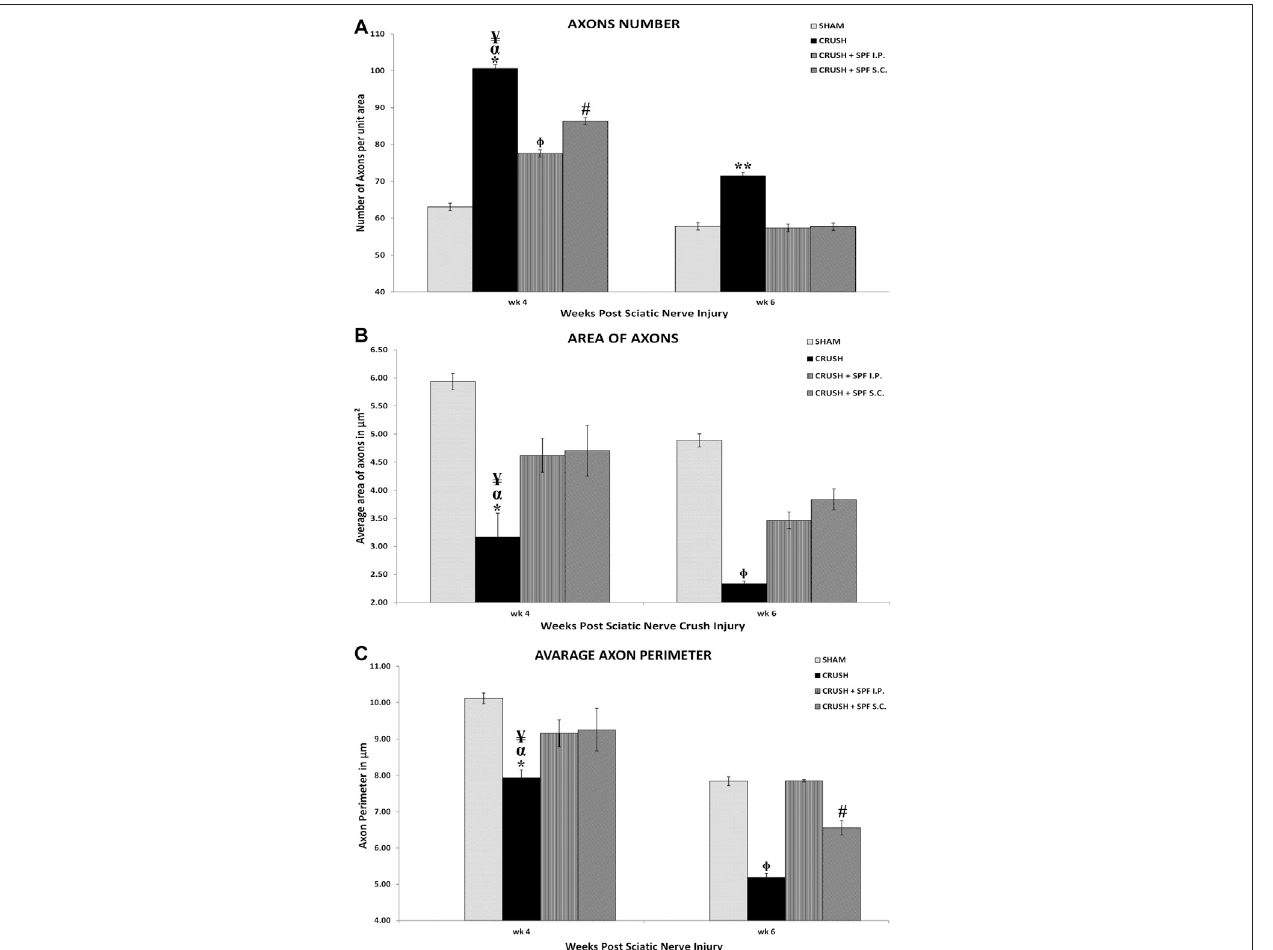
FIGURE 5 | (A) : Number of axons/ fi eld (at × 1,000 magni fi cation) in a cross-section of the sciatic nerve distal to the injury site. Note SPN treatments signi fi cantly decreasedthenumberofaxons/ fi eldfollowingnervecrushinjuryatWeek4.Further,thenumberofaxons/ fi eldoftheSPF-FB-treatedgroupsreturnedtotheSHAMlevel by Week 6. * indicates p < 0.0001 CRUSH vs. SHAM; α indicates p < 0.001 CRUSH vs. CRUSH +0.5X SPF-FB(IP); ¥ indicates p < 0.01 CRUSH vs. CRUSH +1X SPF- FB(S.C.); Φ indicates p < 0.02CRUSH+0.5XSPF-FB(IP)vs.SHAM;#indicates p < 0.001CRUSH+1XSPF-FB(S.C.)vs.SHAM;**indicates p < 0.005CRUSHvs. all groups. (B) : The Crush + SPF-FB animalsshowed a signi fi cant increasein the mean cross-sectional areas of the myelinated axons at Week 4 and Week 6 compared withtheCrushgroup.*indicates p < 0.002CRUSHvs.SHAM; α indicates p < 0.01CRUSHvs.CRUSH+0.5XSPF-FB(IP);¥indicates p < 0.05CRUSHvs.CRUSH+1X SPF-FB(S.C.); Φ indicates p < 0.01CRUSHvs.allgroups. (C) :TheCRUSH+SPF-FB-treatedanimalsshowedasigni fi cantincreaseinthemeancross-sectionalareasof the myelinated axons at Week 4 and Week 6 compared to the CRUSH group. * indicates p < 0.002 CRUSH vs. SHAM; α indicates p < 0.02 CRUSH vs. CRUSH + 0.5X SPF-FB(IP);¥indicates p < 0.03CRUSHvs.CRUSH+1XSPF-FB(S.C.); Φ indicates p < 0.0001CRUSHvs.allgroups;#indicates p < 0.003CRUSH+1XSPF-FB(S.C.) vs. CRUSH + 0.5X SPF-FB(IP). (D – F) : Stereological estimation of the myelinated axon diameter (D) , myelinated nerve fi ber diameter (E), and myelin thickness (F) obtained from 10 different random samples from each group (n (cid:2) 5). (D) : The CRUSH animals displayed a signi fi cant decrease in axon diameter at all the time points assessed following nerve injury compared with SHAM and CRUSH + SPF-FB-treated groups. The CRUSH + SPF-FB-treated group showed no signi fi cant change in comparisonwithSHAManimalsatWeek4andWeek6.*indicates p < 0.002CRUSHvs.SHAM; α indicates p < 0.01CRUSHvs.CRUSH+0.5XSPF-FB(IP);¥indicates p < 0.03 CRUSH vs. CRUSH + 1X SPF-FB(S.C.); Φ indicates p < 0.03 CRUSH vs. All groups. E: Likewise, the CRUSH group displayed a signi fi cant decrease in nerve fi ber diameter at all the time points assessed following nerve injury compared with SHAM and CRUSH + 0.5X SPF-FB(IP) groups. * indicates p < 0.001 CRUSH vs. CRUSH + 0.5X SPF-FB(IP); ¥ indicates p < 0.0001SHAM vs. All treated groups; Φ indicates p < 0.04 CRUSH vs. CRUSH + 0.5X SPF-FB(IP). (F) : The calculated myelin thickness for the CRUSH and CRUSH + SPF-treated groups show a signi fi cant decrease in myelin thickness compared to SHAM animals at Week 4 and Week 6 following sciatic nerve injury. However, the myelin thickness in CRUSH + SPF-treated animals increased signi fi cantly at Week 4 and became more at Week 6 compared withtheCRUSHgroup.¥indicates p < 0.01SHAMvs.Allgroups;*indicates p < 0.003CRUSHvs.CRUSH+0.5X;SPF-FB(IP); α indicates p < 0.05CRUSHandCRUSH + 1X SPF-FB(S.C.) vs. CRUSH + 0.5X SPF-FB(IP); Φ indicates p < 0.007 CRUSH vs. CRUSH + 0.5X SPF-FB(IP) and CRUSH + 1X SPF-FB(S.C.). Values are expressed as means and SDs ( error bars ). (G) : Western blot analysis of myelin basic protein (MBP) in the sciatic nerves from the experimental groups (n (cid:2) 5) at Week 4 and Week 6 followingnerveinjury.NotethickMBPbandsintheCRUSH+SPF-FB-treatedgroup. (H) :BargraphshowstheMBPdensityindistalnervesamplesnormalizedwithactin banddensities.Notesigni fi cantlyincreasedbasicmyelincontentintheSPF-treatedgroupatWeek4andWeek6postsciaticnerveinjury.*indicates p < 0.0001CRUSH vs. All groups; Φ indicates p < 0.02 NAÏVE vs. CRUSHv0.5X SPF-FB(IP); ¥ indicates p < 0.0001 NAÏVE vs. CRUSH + 1X SPF(S.C.); # indicates p < 0.02 SHAM vs. CRUSH +0.5X SPF(IP); ** indicates p < 0.0001 CRUSH vs. NAÏVE and SHAM; α indicates p < 0.01 CRUSH vs. treated groups; αα indicates p < 0.0001 CRUSH + 0.5X SPF-FB(IP) vs. NAÏVE. All values are expressed as means + SDs (error bars).